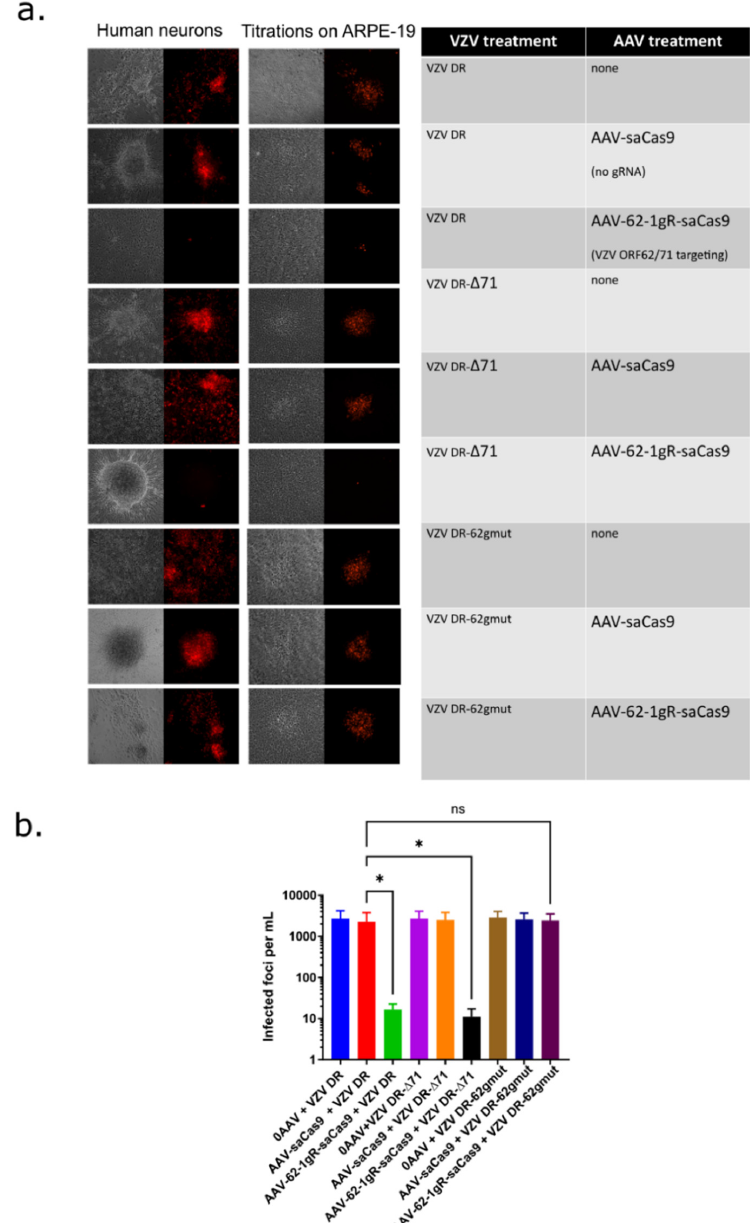
Figure 5. Pretreatment with AAV-62-1gR-saCas9 knockdown of VZV lytic replication in exogenously infected human neuron cultures. ( a ) The 12-well plates of hESC neuron cultures were transduced with 104 GC/cell of AAV-62-1gR-saCas9 constructs/well. Four days later, neurons were infected with 500 PFU of mitotically inhibited fluorescent (red)-cell associated VZV-infected cells to initiate lytic infections. Infections were subsequently monitored by fluorescence microscopy and representative images of mCherry reporter expression of infected cells and the same fields observed by phase contrast microscopy were acquired 10 days after VZV infection. ( b ) After imaging, duplicate infected neuron cultures were scraped, triturated, and then seeded onto confluent ARPE-19 cells to quantify the number of VZV-infected neurons by the number of infectious foci they generated. Foci were counted after 5 days. Representative images of foci formed on ARPE-19 at day 5 from virus obtained from the treated neuron cultures are shown in column 2 of Figure 5a. Data represents quadruplicate measurements and significant differences between treatments depicted by asterisks (* = p < 0.01, ordinary one-way ANOVA with multiple comparisons; ns = not significant). Similar results were obtained in two independent experiments. Error bars depict the STD.